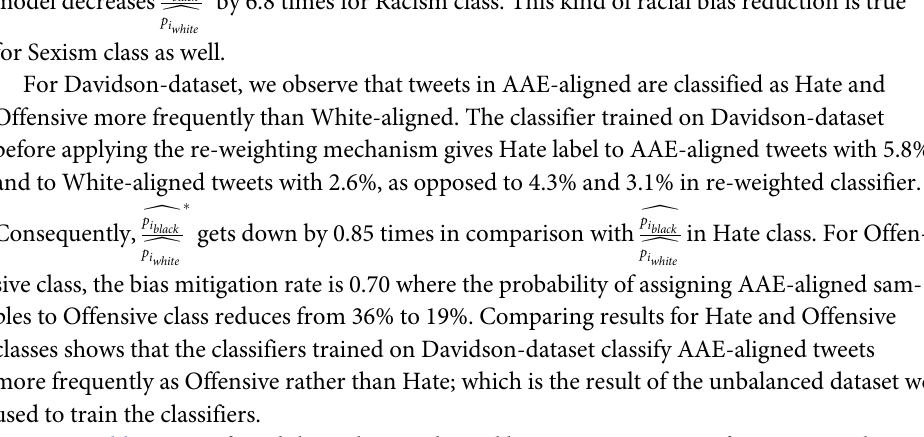
Table 5. Performance evaluation after applying the re-weighting mechanism. To quantify the impact of the re-weighting mechanism in the performance of our pre- trained BERT-based model (with BERT BASE strategy for fine-tuning), we examine the classifier trained on Waseem and Davidson datasets with and without re-weighting mechanism on the training set in terms of macro precision, recall, and F1-measure.